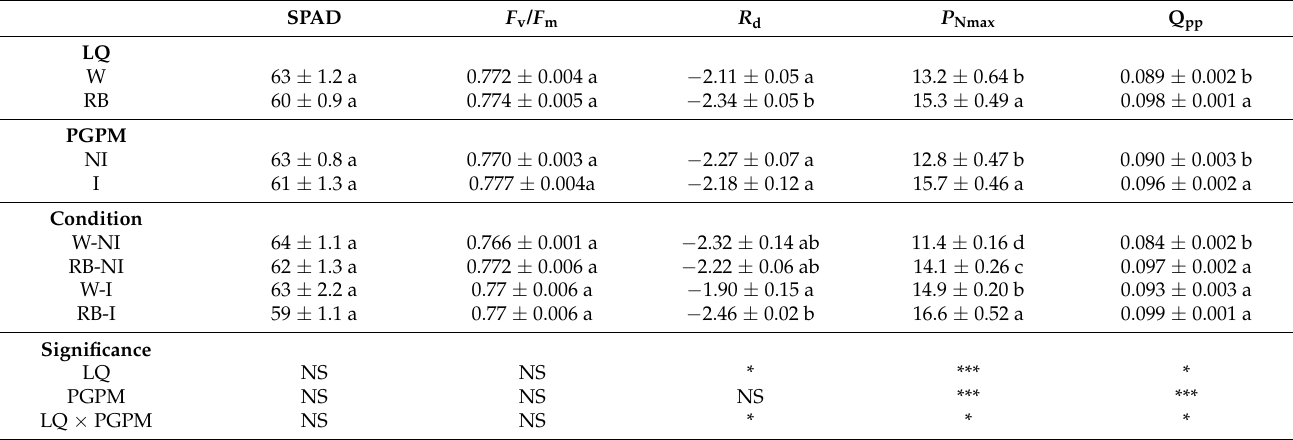
SPAD: Soil Plant Analysis Development chlorophyll index; F v / F m : maximal photochemical efficiency of pho- tosystem II; R d : dark respiration; P Nmax : light-saturated net photosynthesis; Q pp : apparent light efficiency. Photosynthesis data derived from LRC. Data are means ± standard error (n = 5). Different letters denote significant